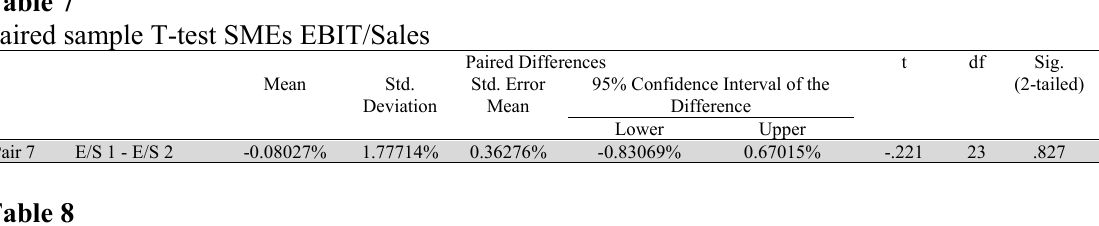
Paired sample T-test SMEs Operating Ratio